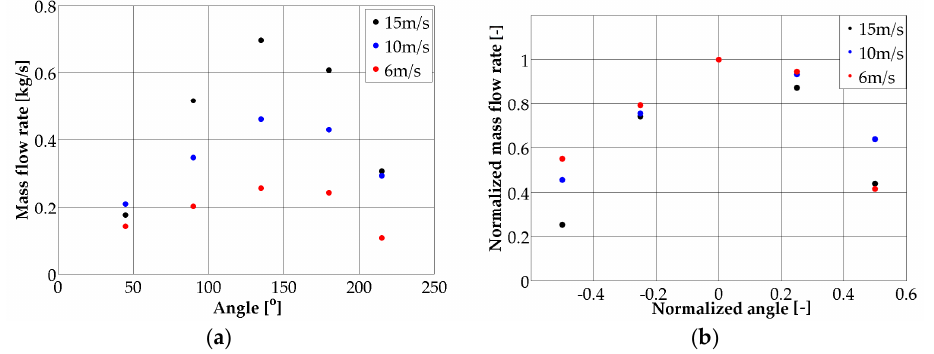
Figure 7. Computational Fluid Dynamics (CFD) results for mass flow rate versus wind direction: (a) absolute values, (b) normalized values.